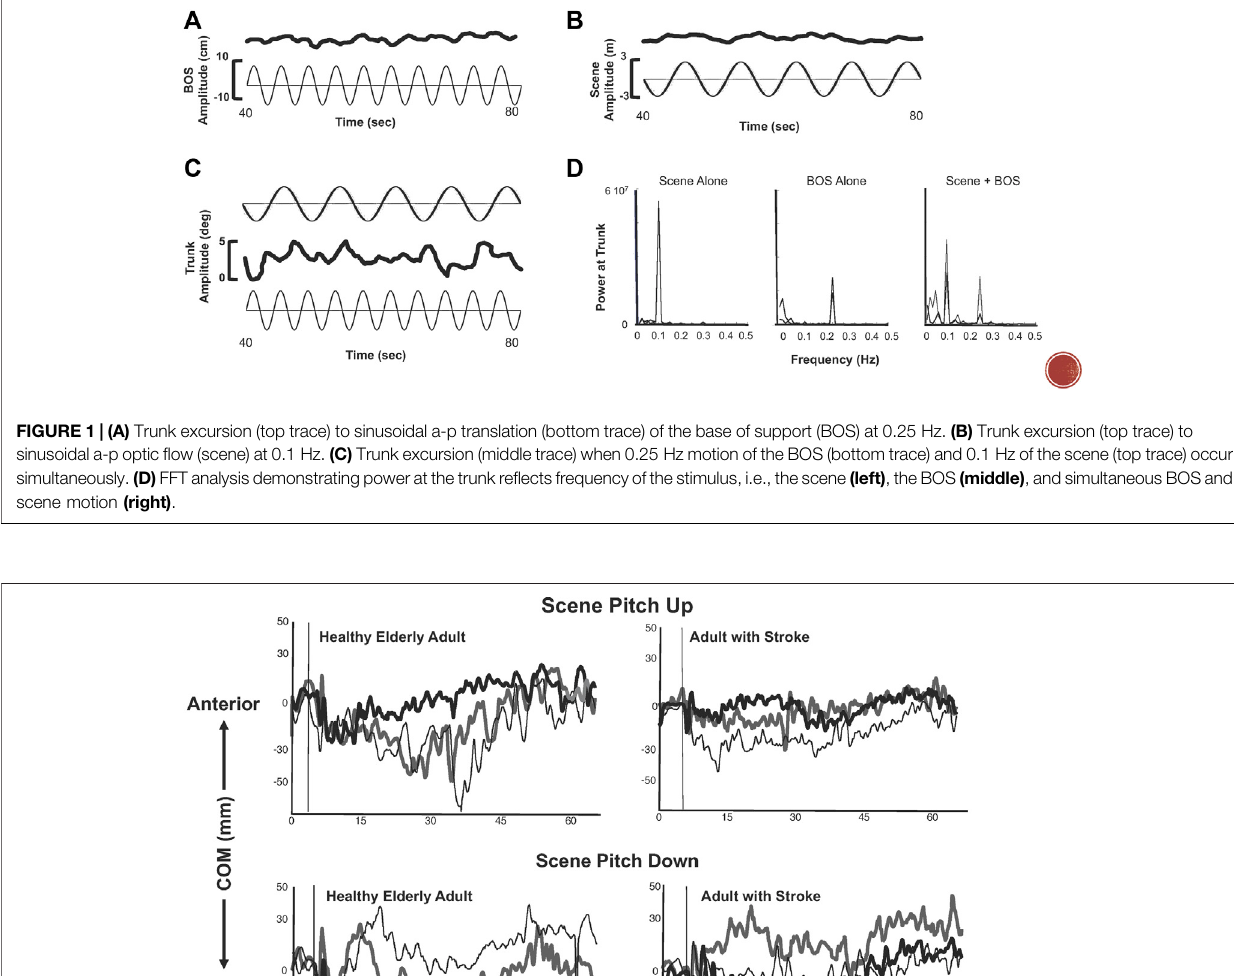
Frontiers in Virtual Reality |